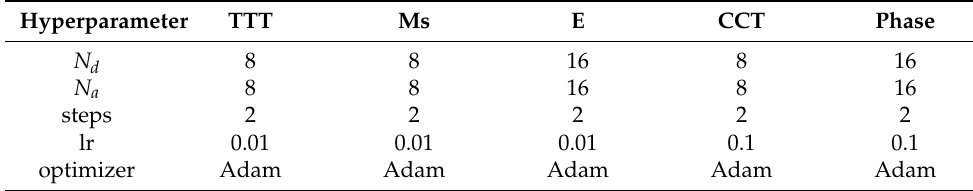
Table 1. Hyperparameters of each task model.